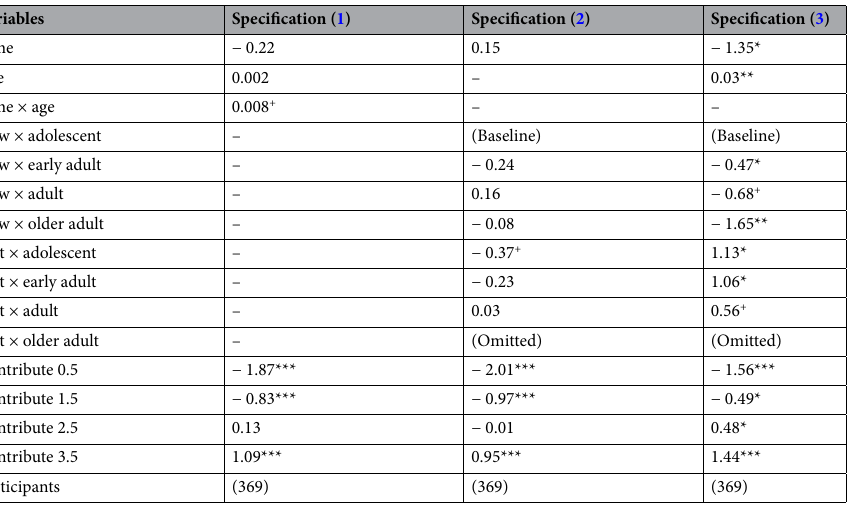
Table 1. Ordered probit estimates for specifications (1), (2) and (3). The ordered Probit approach transforms the discrete dependent variable in a continuous one, and the rows in the table labelled Contribute X represent different cut-offs for the transformed dependent variable above which participants contribute more than X tickets and below which they contribute less than X tickets. Our key specification (3), displays a significant coefficient for almost all parameters and underlies the graphical representation provided in Fig. 1d (Please note that the variable “fast × older adult” is omitted from regressions because of collinearity. The coefficient on variable “slow × adolescents” is omitted from regressions because of collinearity). Qualitatively similar results hold when age is dropped as an explanatory variable, in specification (2). However, many coefficients lose significance, as interaction terms are less precisely estimated when accounting also for the age variation in PGG contributions within age groups. When age is treated as a continuous variable in the interaction term, contributions of those under time-delay do not vary with age whereas contributions of those under time pressure increase with age (although p-value on the coefficients being different is only 0.14). + p < 0.15 (marginally significant), * p < 0.05, ** p < 0.01, *** p < 0.001.